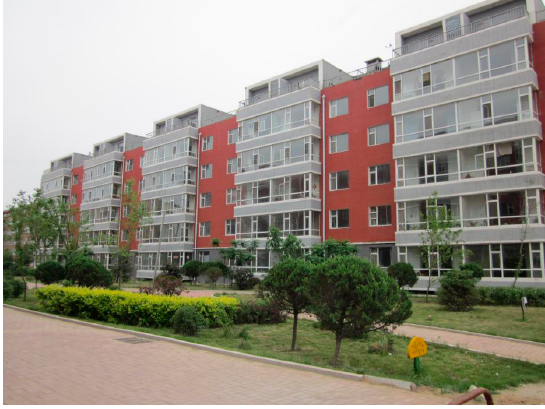
Figure 4. Housing in the resettlement community.